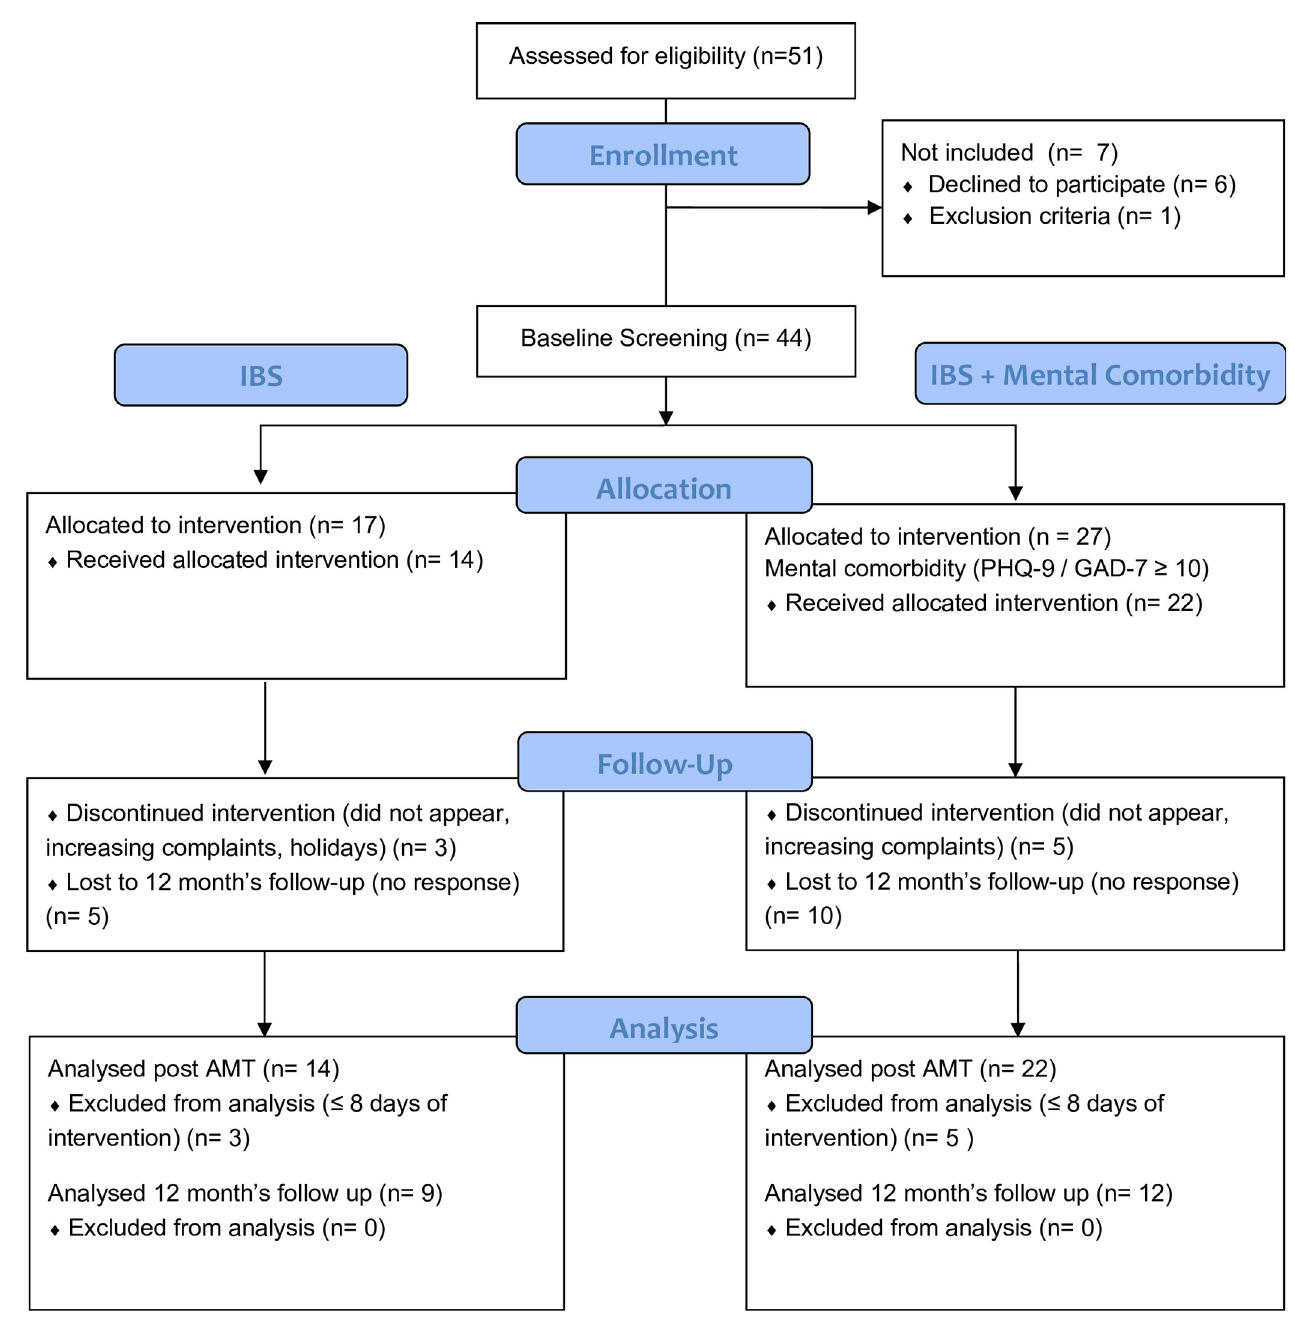
Fig 1. Flow chart of the